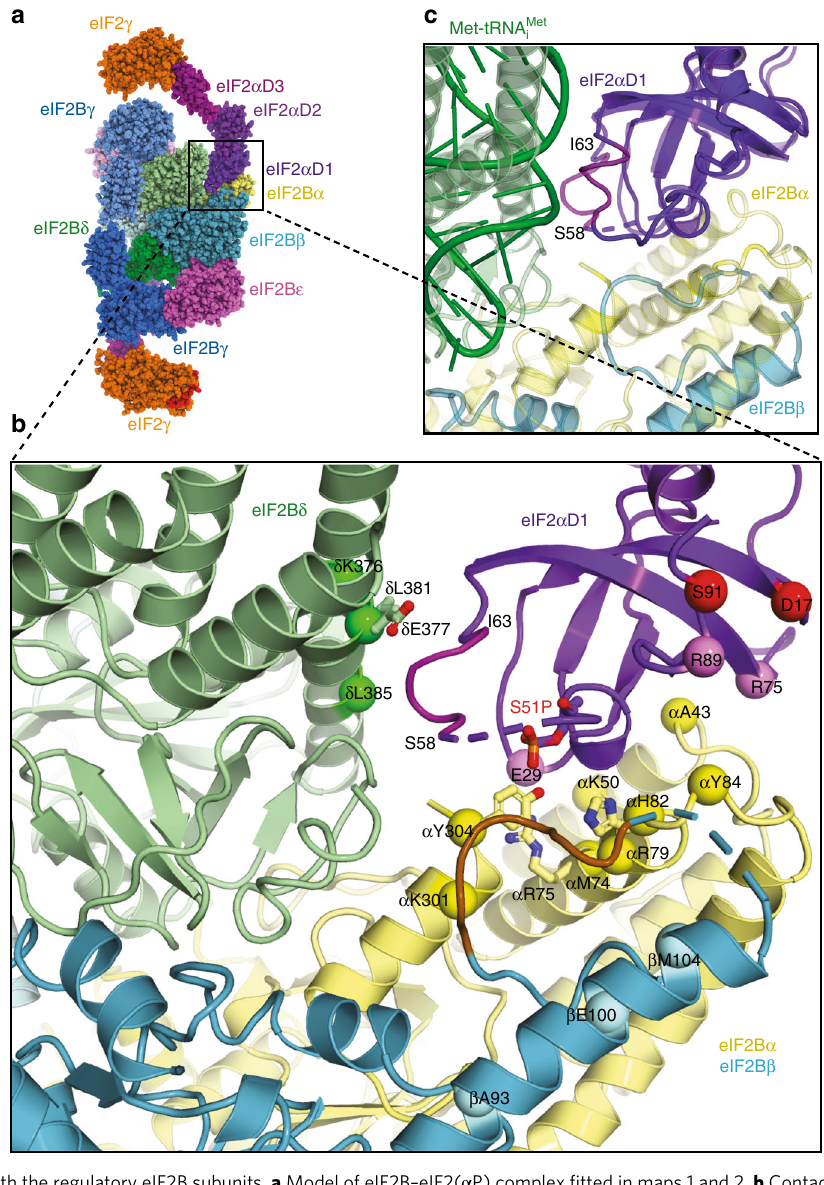
Fig. 2 Contacts of eIF2 α with the regulatory eIF2B subunits. a Model of eIF2B – eIF2( α P) complex fi tted in maps 1 and 2. b Contacts of eIF2 α -D1 with α , β and δ regulatory subunits of eIF2B. Possible residues in contacts with eIF2 α Ser51 phosphate (red sticks) are H82, Y304 and R75 in eIF2B α (shown in yellow sticks). eIF2B δ E377 (green sticks) in contact with the 56 – 63 helix (magenta) of eIF2 α affected by the phosphate is also shown. eIF2B δ E377K overcomes the effect of Ser51 phosphorylation and eIF2B β I118T and S119P (in brown loop) reduce the effect of phosphorylation. Also shown are residues in S . cerevisiae eIF2B regulatory subunits α , β and δ corresponding to S . pombe residues which cross-linked to eIF2 α and residues in eIF2 α which cross-linked to eIF2B α (pink spheres) and to eIF2B β (red spheres) 28 . c Superposition of eIF2 α -D1 in eIF2B – eIF2( α P) complex and in the TC (PDB 3JAP), showing that the same helix 58 – 63 (coloured magenta) in eIF2 α -D1 interacts with both eIF2B δ and Met-tRNA i Met in a different conformation, suggesting direct competition for eIF2 α